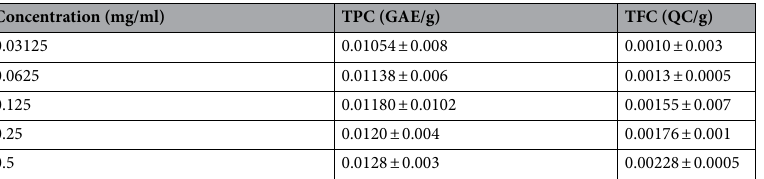
Table 1. Total phenol (TPC) and flavonoid contents (TFC) of the CPE (crude polyphenolic extract). Values are presented as the mean ± standard error mean ( n = 3).